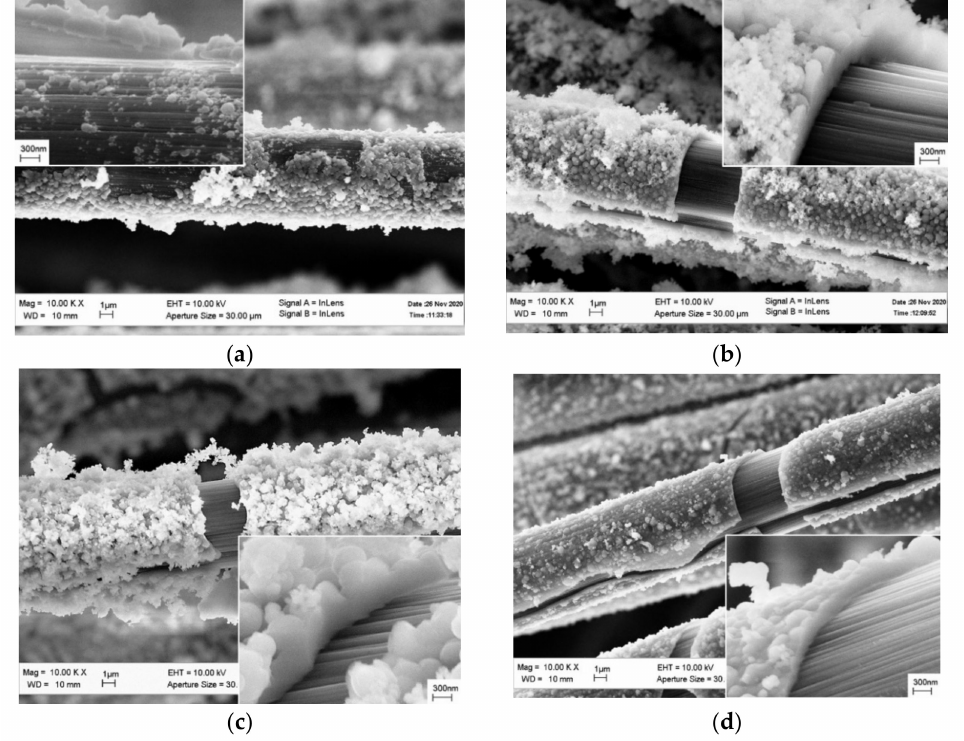
Figure 9. Surface of the coated carbon fiber formed in the reaction media with different IPA concentrations: ( a ) 40%, ( b ) 50%, ( c ) 57%, ( d ) 78%. Table 4. The parameters of the reaction medium for determining the IPA concentration effect. C IPA ,